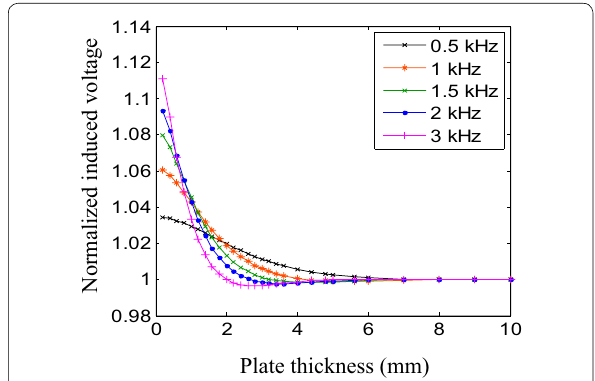
Figure 10 Relation between coil voltage due to EC and plate